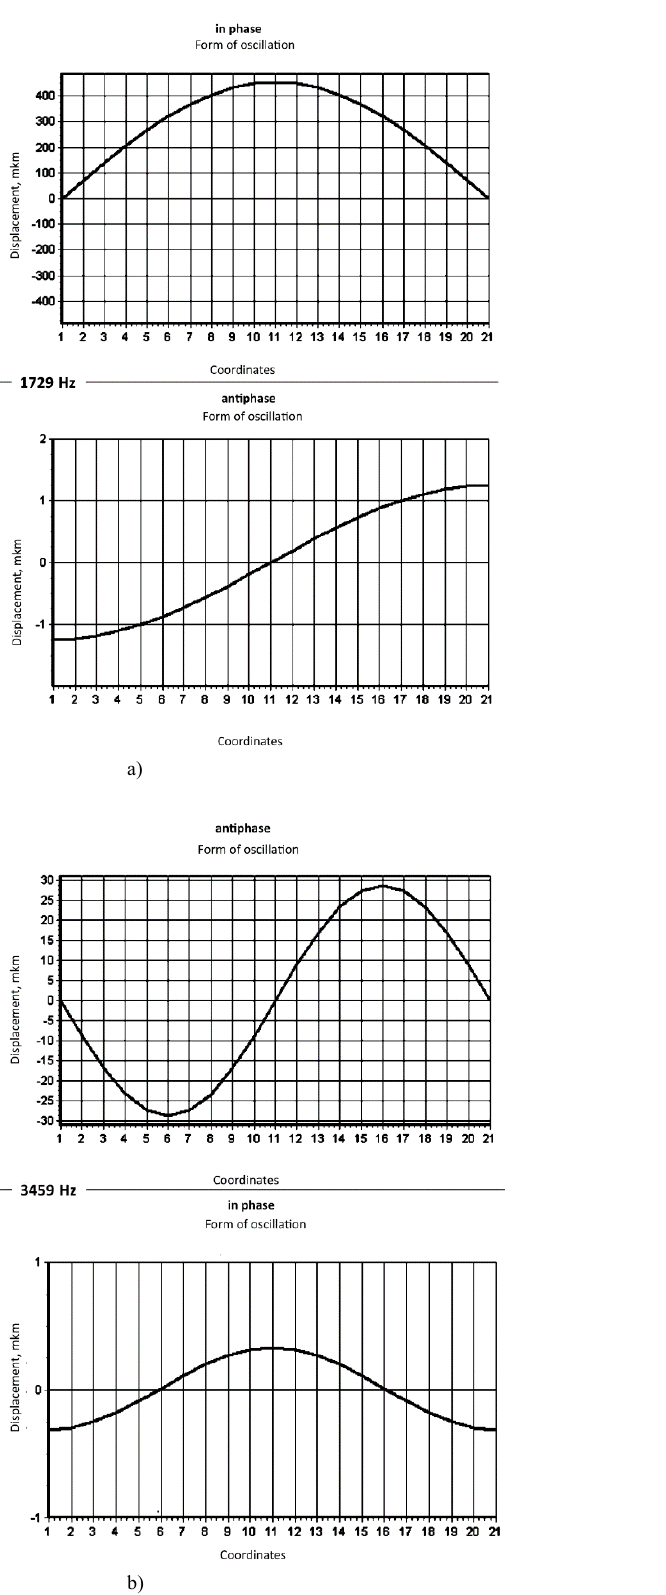
Fig. 7. Distribution of displacement amplitudes during the standing wave formation in the